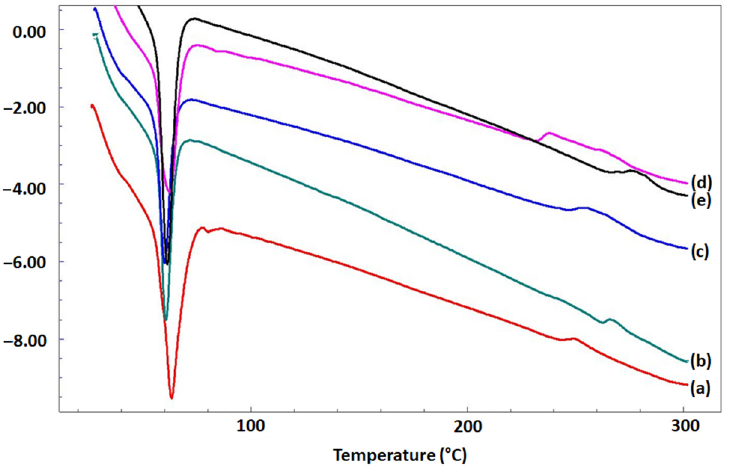
Figure 4. DSC curves of 25% PCL ( a ) , 25% PCL/0.1% BFO ( b ), 25% PCL/0.1% BFO/1Q ( c ), 25% PCL/0.1% BFO/3Q ( d ) and 25% PCL/0.1% BFO/5Q ( e ) microfibrous scaffolds.